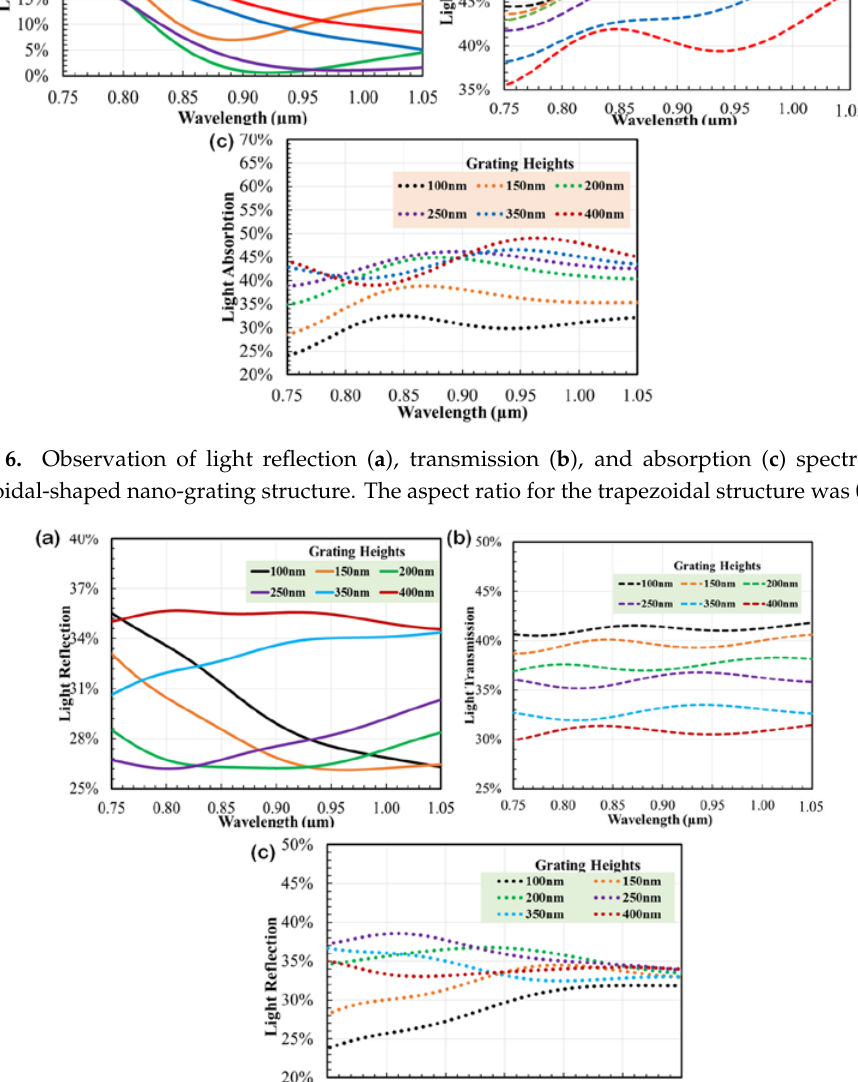
Figure 6. Observation of light reflection ( a ), transmission ( b ), and absorption ( c ) spectra for a trapezoidal-shaped nano-grating structure. The aspect ratio for the trapezoidal structure was 0.5.